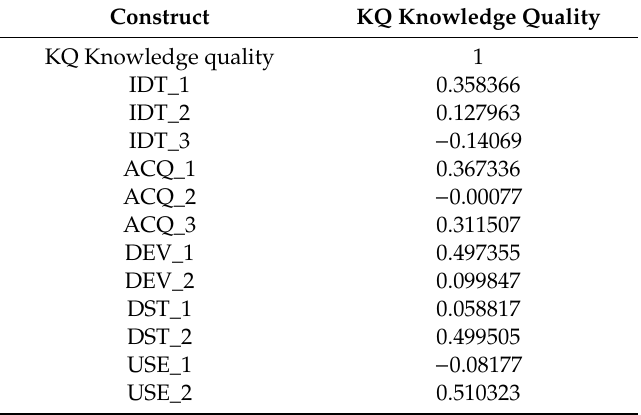
Table 3. Results of linear correlation analysis measured with the Pearson coe ffi